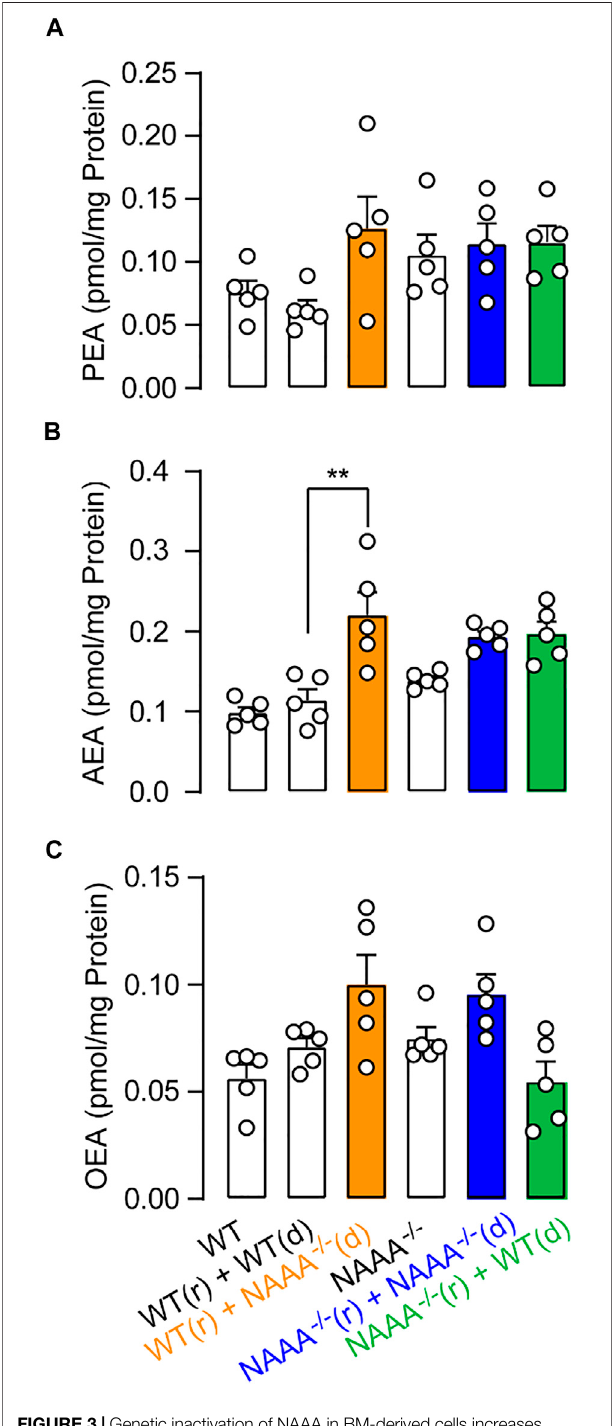
FIGURE 3 | Genetic inactivation of NAAA in BM-derived cells increases PEA and AEA levels in lungs. BM isolated from WT (d) or NAAA -/- (d) micewas individually transferred into lethally irradiated WT (r) or NAAA -/- (r) mice. Chimeras were used for HPLC-MS studies 8 weeks after initial reconstitution. (A) PEA, (B) AEA and (C) OEA levels in lungs in chimera mice. Data are expressed as mean ± SEM ( n (cid:1) 5). *, p < 0.05; **, p < 0.01; ***, p < 0.001 by t